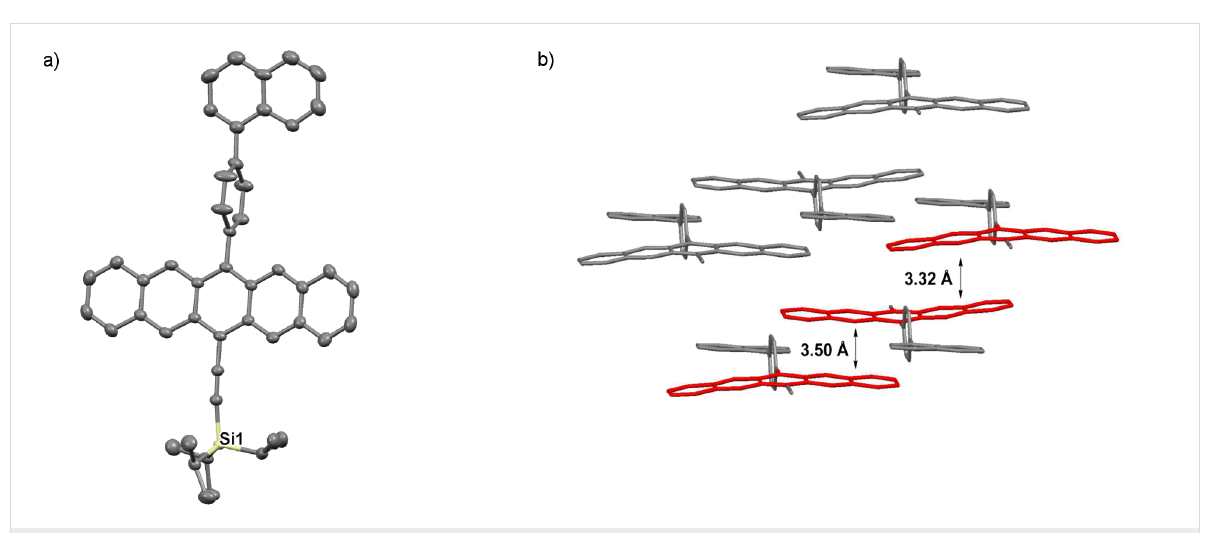
while the intervening benzene ring is nearly perpendicular to both the pentacene skeleton (~90°) and the naphthyl group (~86°). Compound 3j arranges in a 1D slipped stack arrange- ment along the crystallographic b -axis with two different inter- planar distances of ~3.50 Å and 3.32